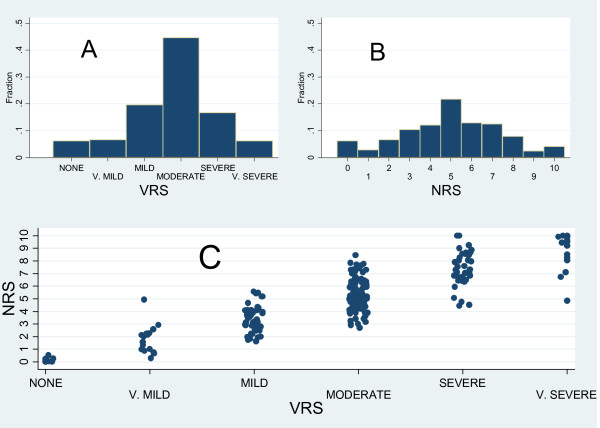
Scores distribution of background pain intensities as measured by VRS (A) and NRS (B) and scatter plot * of the two measures (C). Detailed legend: *In order to avoid an high number of points plotted on top of each other, points have been artificially distributed round their real original position.